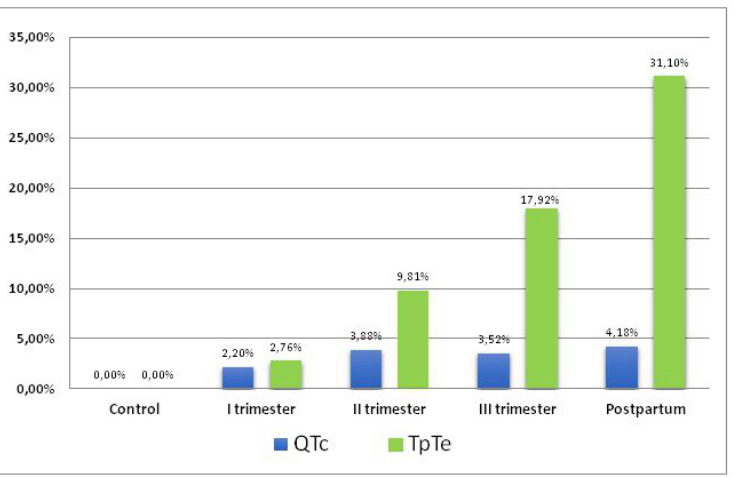
Figure 4. Values of QTcB and TpTe intervals in relation to the control group during pregnancy and